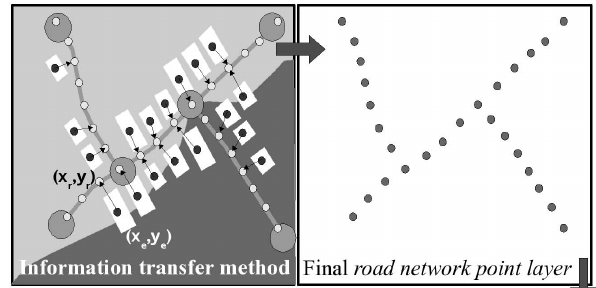
Fig. 4. (A) Information transfer from the buffer polygon layer, zone polygon layer, edifice point layer and locality point layer to the road network point layer. For this, two methodologies are applied: 1) spatial join, we detect which features of the road network point layer are included in the different features of the buffer and zone polygon layers, and transfer the contained information in the attribute tables of both polygon layers to the one of the point layer; 2) join by prox- imity, we calculate the shortest distance (using x , y coordinates) be- tween features of the locality and/or edifice point layers and those of the road network point layer; then, we transfer the inhabitants value to the features of the road network point layer. One point of the road network point layer, can store inhabitants from different edifices or